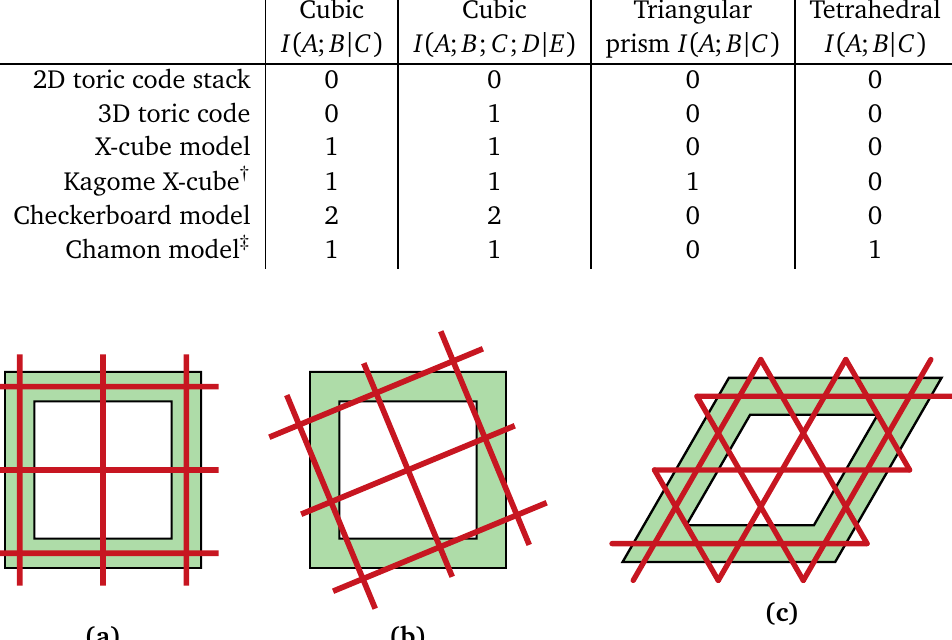
Figure 4: A side-view of the cubic entanglement regions (green) from Fig. 3(a-b) for different possible orientations with respect to the foliating layers (red). (a) Proper alignment on a cubic lattice, yielding the values Table 1. (b) Improper